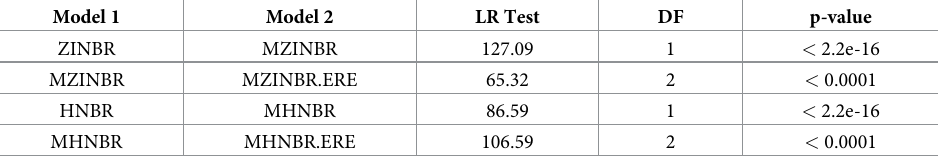
Table 4. Likelihood Ratio (LR) tests for the nested zero-inflated NBR (ZINBR), mixed ZINBR (MZINBR), mixed ZINBR with extra random effects in the zero part (MZINBR.ERE) models, and hurdle NBR (HNBR), mixed HNBR (MHNBR), and mixed HNBR with extra random effects in the zero-part (MHNBR.ERE)